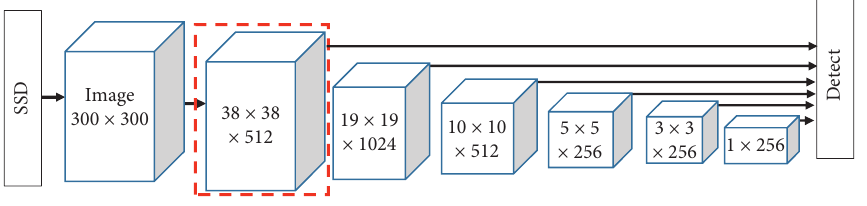
Figure 10: Calculation of loss function in